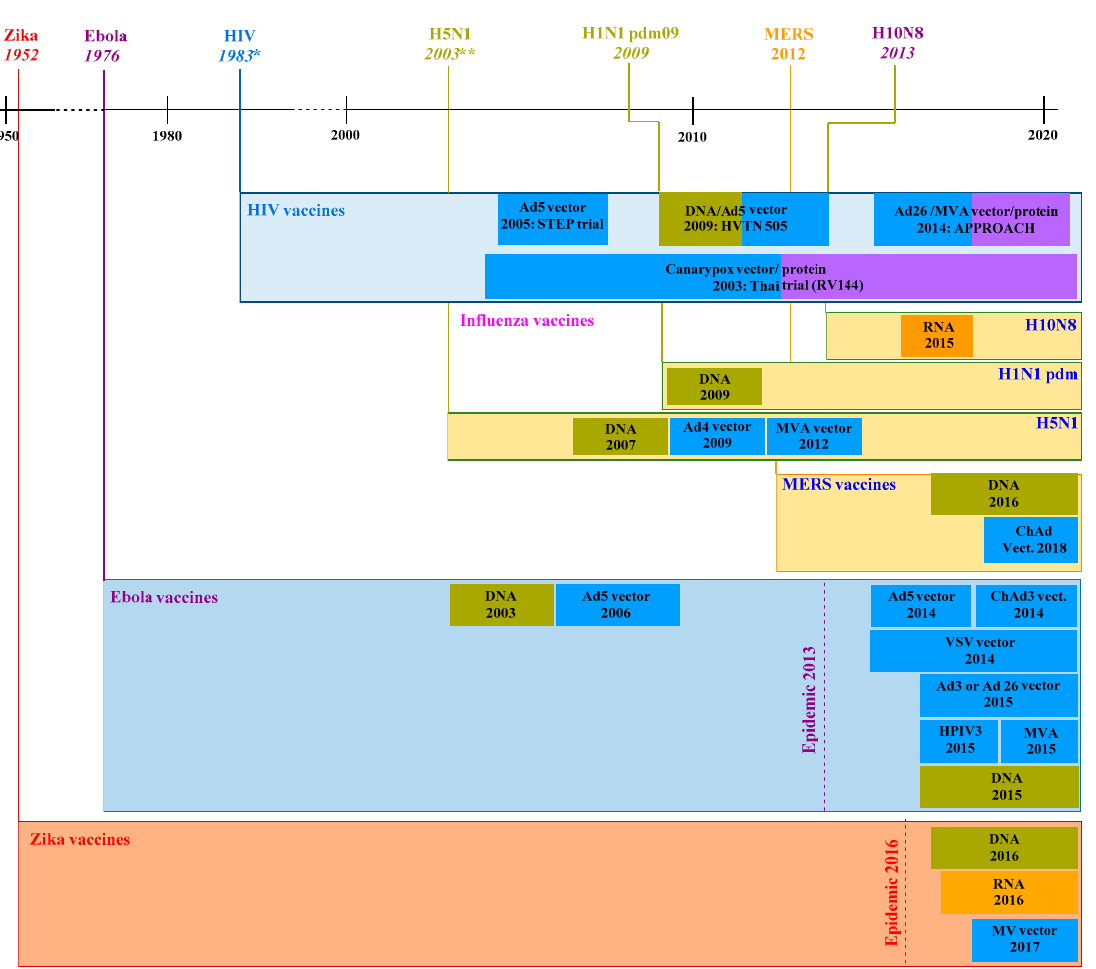
Figure 5. The onset of the clinical vaccine’s development against massive outbreaks. Ad4, 5, or 26 vectors (human adenovirus type 4, 5, or 26); ChAd (chimpanzee adenovirus); MVA (modified vaccinia Ankara); VSV (vesicular stomatitis virus); HPIV3 (human parainfluenza virus type 3); MV (measles virus). Redrawn with permission from [72] , an open access article (CC BY).